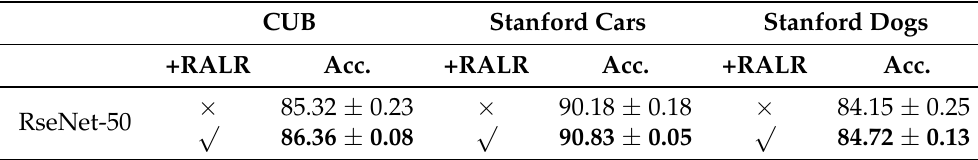
Table 3. Validation accuracy (%) of ResNet-50 on different fine-grained tasks. CUB